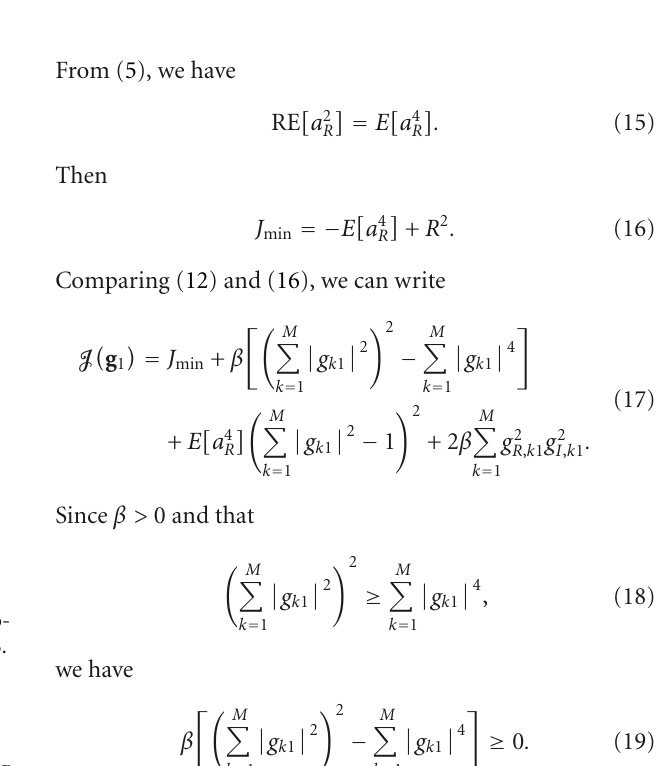
Figure 3: 4-PSK constellation. Left column: the constellations of the transmitted signals, middle column: the constellations of the received signals (mixtures), right column: the constellations of the recovered signals.